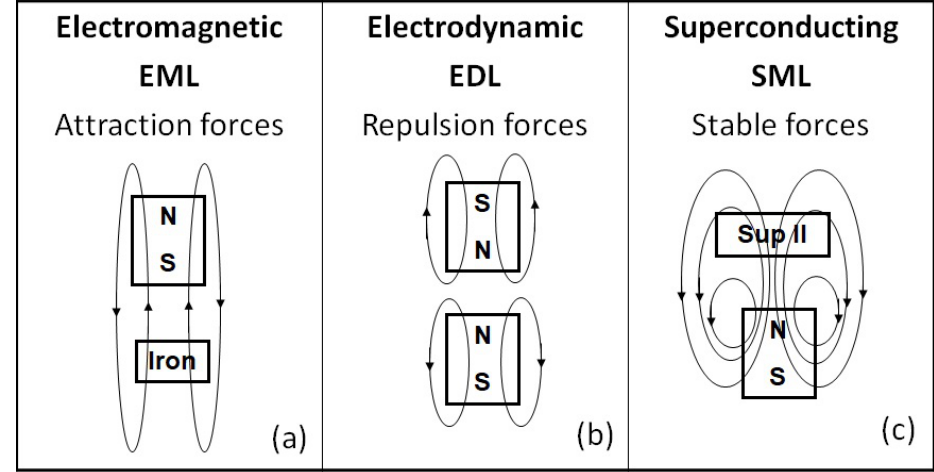
Figure 1. Magnetic Levitation (MagLev)